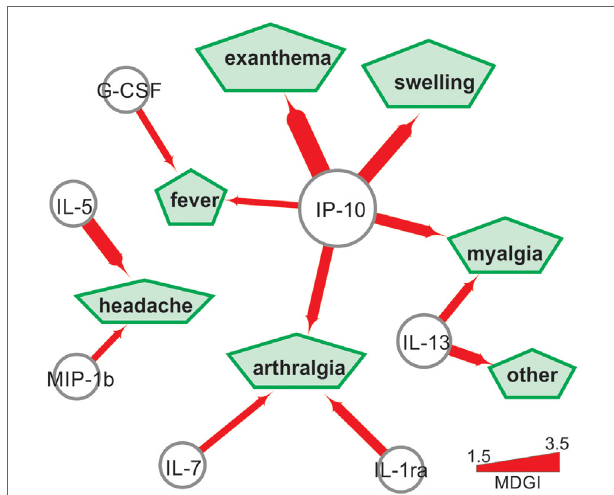
FigUre 5 | Cytokine levels can predict the clinical symptoms of Zika virus­infected subjects. The green pentagons represent clinical symptoms, the nodes represent cytokines and the edges represent the mean decrease of the Gini index (MDGI). Arrow thickness is proportional to the MDGI index.